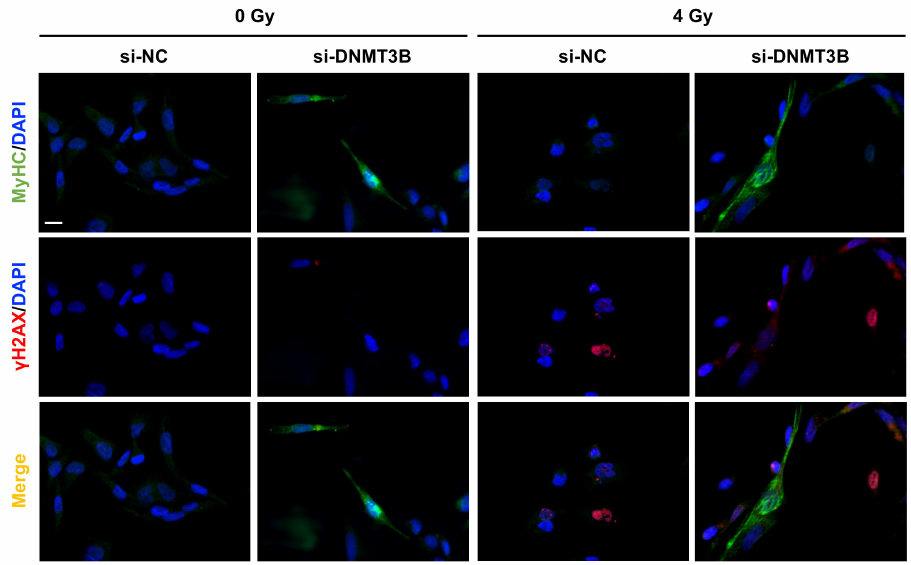
Figure 9. IR induce irreversible DNA damage in undifferentiated si-DNMT3B transfected RD cells. IF assay showing the expression and localization of MyHC and γ -H2AX proteins in RD cells fixed at 7 days after si-DNMT3B transfection and 5 days after irradiation with a single dose of 4 Gy. DAPI was used for nuclear staining. Images were acquired by using ApoTome microscope at 40 × magnification. Scale bar 50 µ